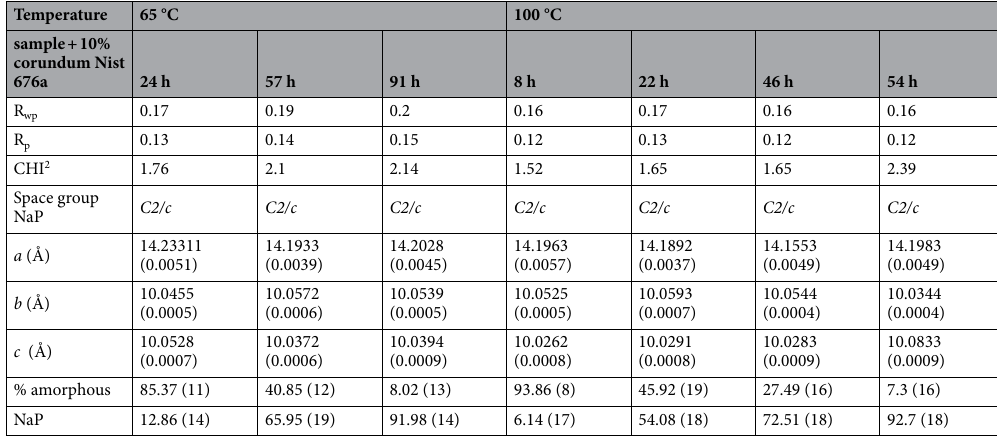
Table 1. Results of the QPA analyses conducted on samples synthesized at 65° and 100